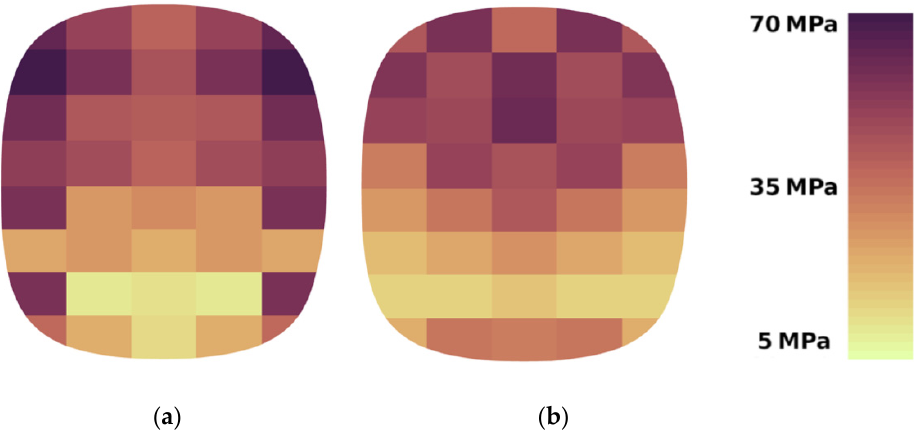
Figure 9. Differences in the stress distribution between the forming surfaces on copper ore concen- trate briquetting at the peripheral speed of working rolls 0.3 m/s: ( a ) forming cavity; ( b ) forming groove.